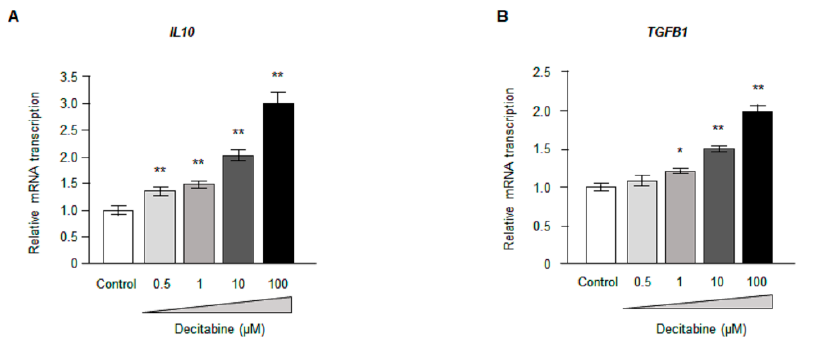
Figure 3. Decitabine dose dependently increased anti-inflammatory cytokine in vitro. ( A , B ) mRNA expression of IL10 ( A ) and TGFB1 ( B ) measured by real-time PCR. The mRNA level was normalized to the mean control value. * p < 0.05, ** p < 0.01 vs. control.